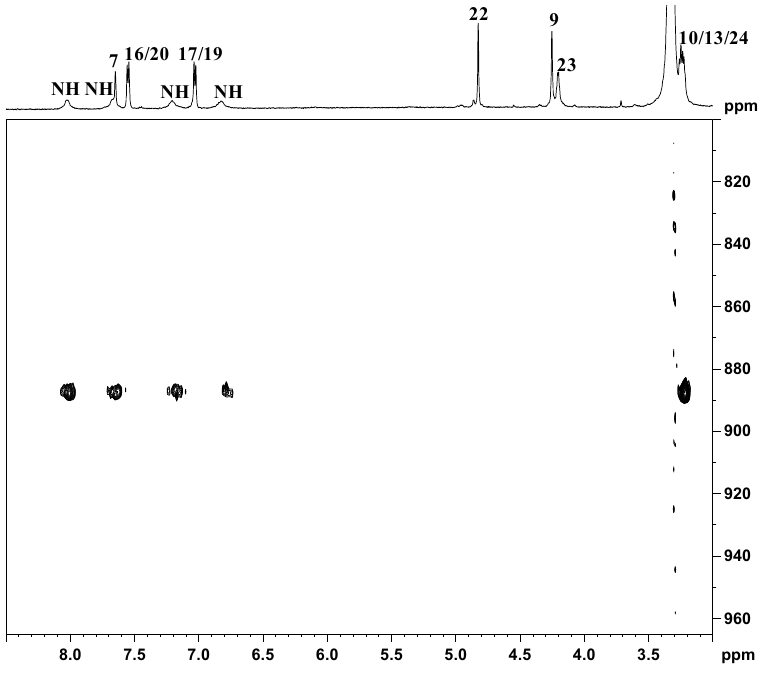
Figure 6. [ 1 H- 195 Pt]-HSQC 2D NMR (300 MHz, 1 H) of 3 in DMSO- d 6 .